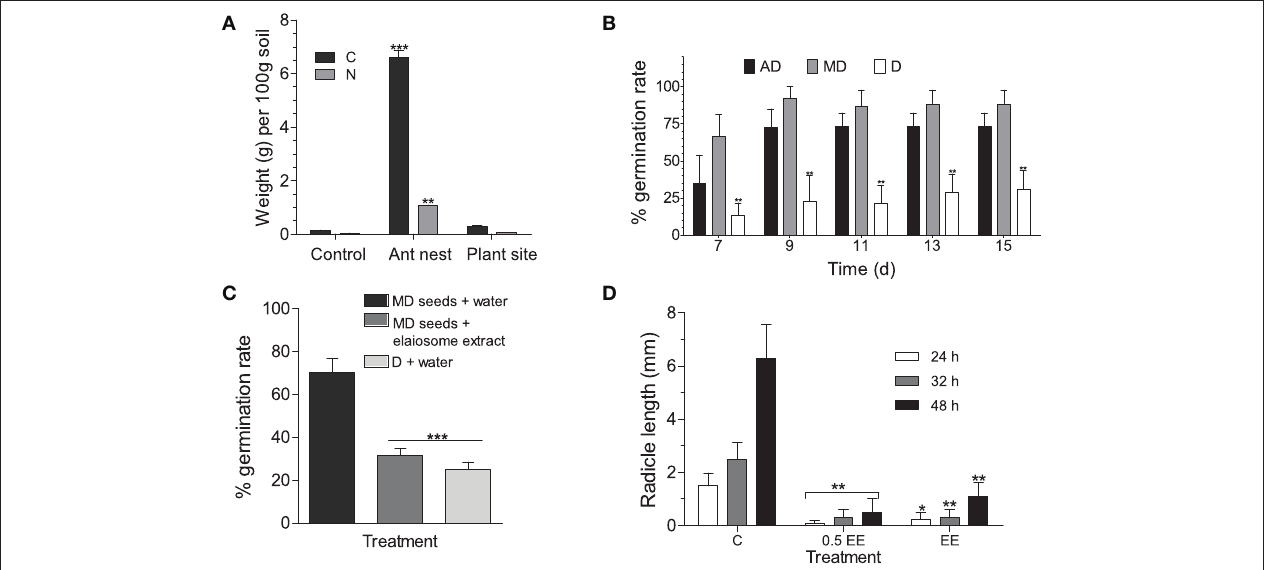
FIGURE 6 | (A) Carbon and nitrogen composition of soil. Data represents mean ± SE. Bonferroni’s post-hoc test was done to separate the means after two-way ANOVA ( p ≤ 0.01, n = 3). (B) Germination assay. Observations were recorded upto 15 days, beyond which no germination was observed. Data represents mean ± SE of appearance of hypocotyl above the soil. Asterisk indicates significant difference between treatments tested using Tukey’s post-hoc test after one-way ANOVA ( p ≤ 0.01, n = 3, 20 seeds per treatment) (D, diaspores; AD, ant-detached seeds; MD, mechanically detached seeds). (C) Germination rates after elaiosome extract treatment. Results were taken upto 15 days, beyond which no germination was observed. Data represents mean ± SE of appearance of hypocotyl above the soil. Tukey’s post-hoc test was done to separate the means after one-way ANOVA ( p ≤ 0.05, n = 6) [D, diaspores; MD, mechanically detached seeds; EE, elaiosome extract; C, control (water)]. (D) Germination of Arabidopsis thaliana Col-0 seeds treated with elaiosome extract against half dilution of extract and control (water)-treated seeds. Radicle length (mm) was used as germination index, shown as mean ± SE. Two-way ANOVA followed by Bonferroni post-tests were used to compare the means of different treatments ( p ≤ 0.01, n = 10) [C, control (water); EE, elaiosome